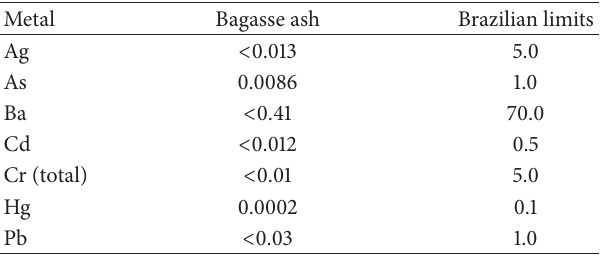
Table 1: Leaching of metals from bagasse ash (mg/L) [18].